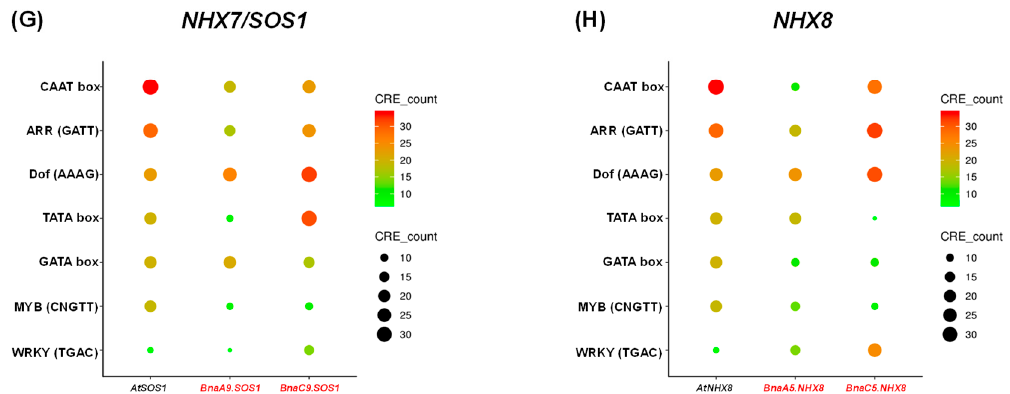
Figure 6. Enrichment analysis of the cis-acting regulatory elements (CREs) in the gene promoter regions of Na +/ H + antiporters (NHXs) in Brassica napus . Enrichment analysis of the CREs in the promoter regions of NHX1s ( A ), NHX2s ( B ), NHX3s ( C ), NHX4s ( D ), AtNHX5 ( E ), NHX6s ( F ), NHX7s / SOS1s ( G ), and NHX8s ( H ). In the scatter plot, the larger the circle size, the more the corresponding